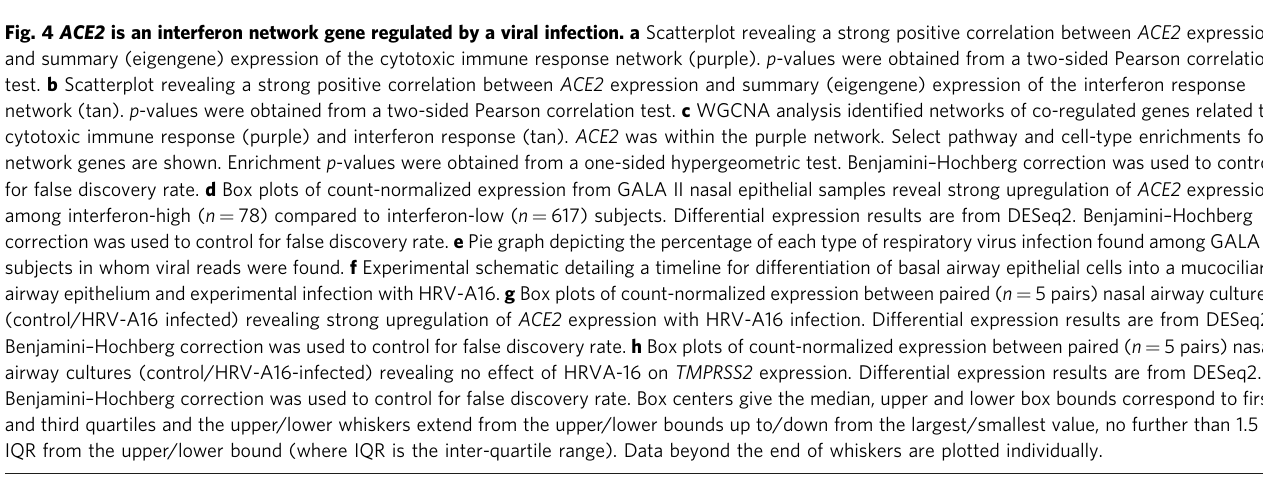
Fig. 4 ACE2 is an interferon network gene regulated by a viral infection. a Scatterplot revealing a strong positive correlation between ACE2 expression and summary (eigengene) expression of the cytotoxic immune response network (purple). p -values were obtained from a two-sided Pearson